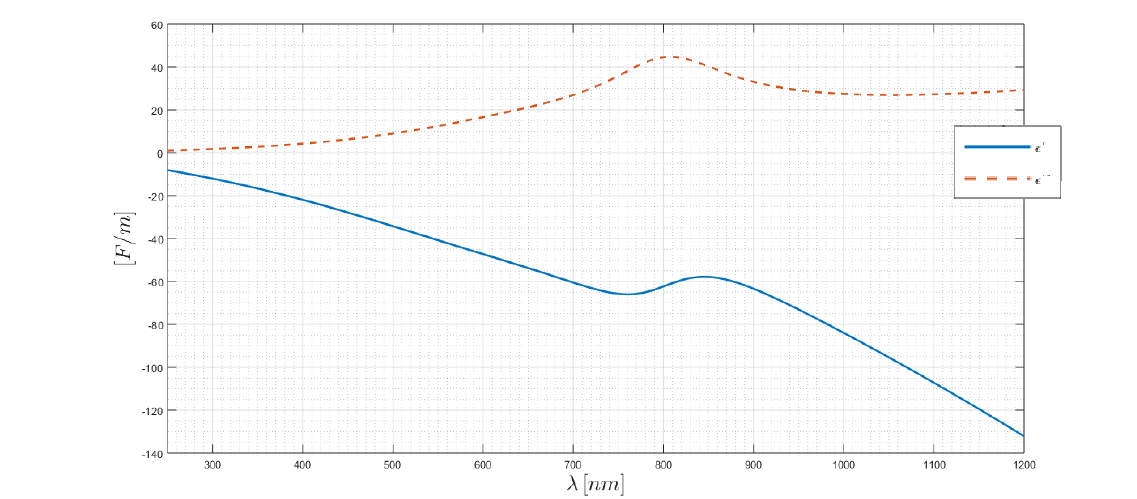
Figure A5. Aluminum complex dielectric function (solid blue line: real part; dashed red line: imaginary